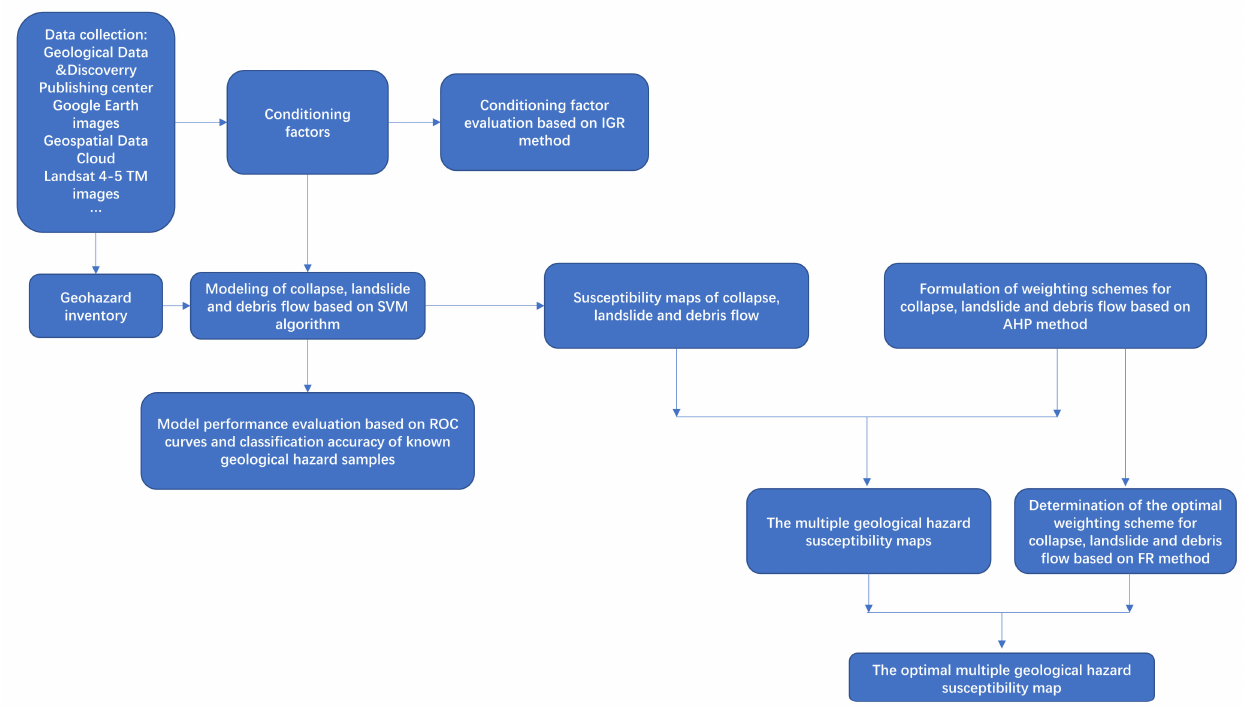
Figure 4. Flowchart of the methodology used in this study.